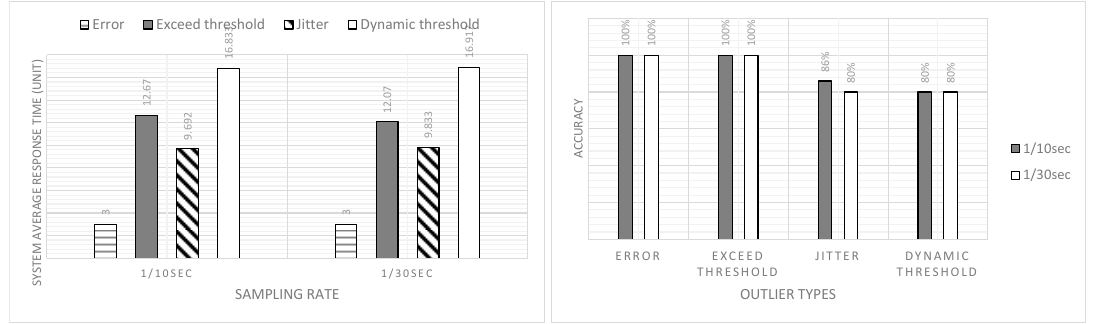
Figure 7. The comparison of the system average response time and accuracy under different sampling rates and fixed network scale (network scale = 1000).